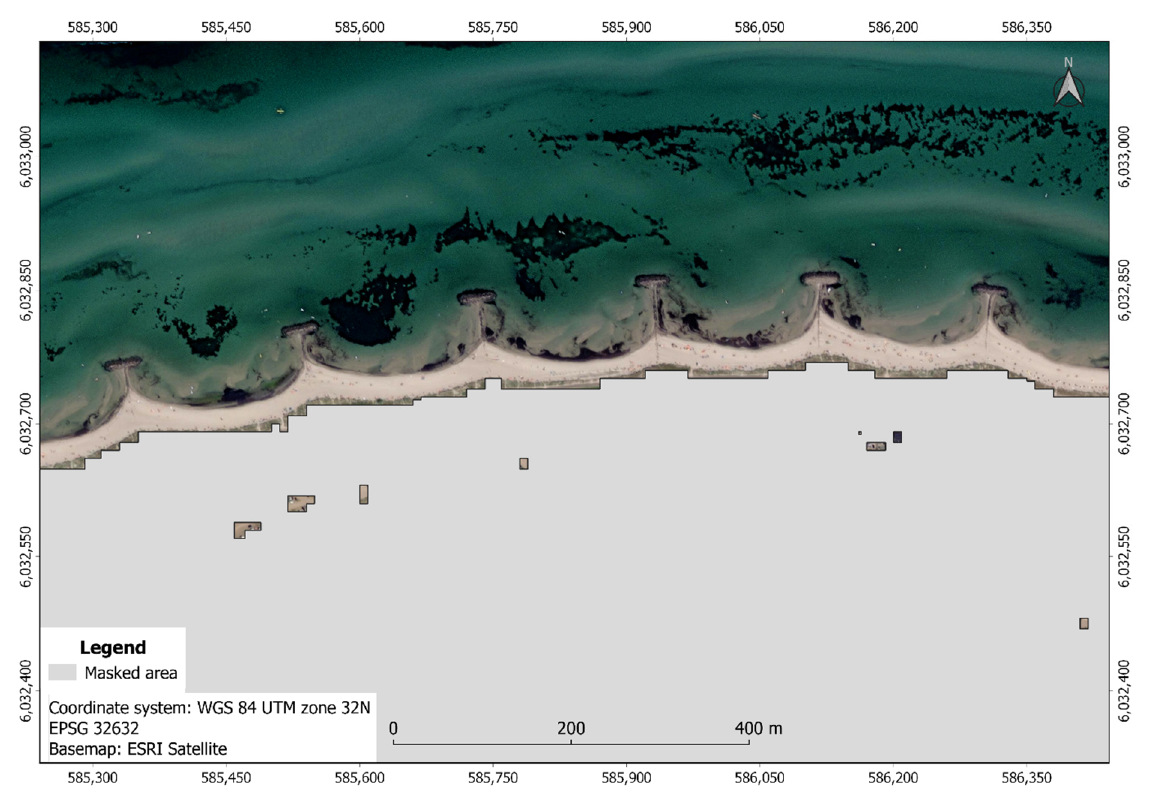
Figure 5. Result of the coastline extraction (example). Grey areas are masked pixels by the ASM approach.